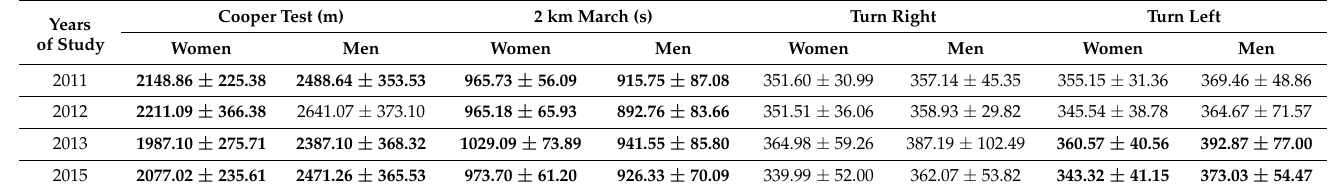
Table 4. Statistical characteristics (mean ± SD) of fitness tests outcomes in research